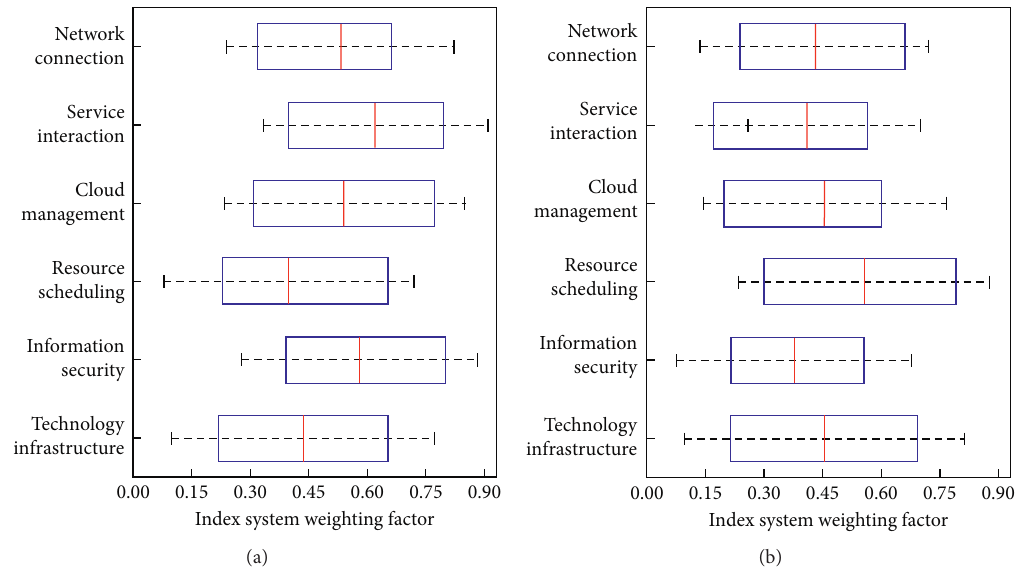
Figure 7: Index systems weighting factors of different indicators in the resource scheduling (a) and strategic management (b) of smart city based on digital economy.